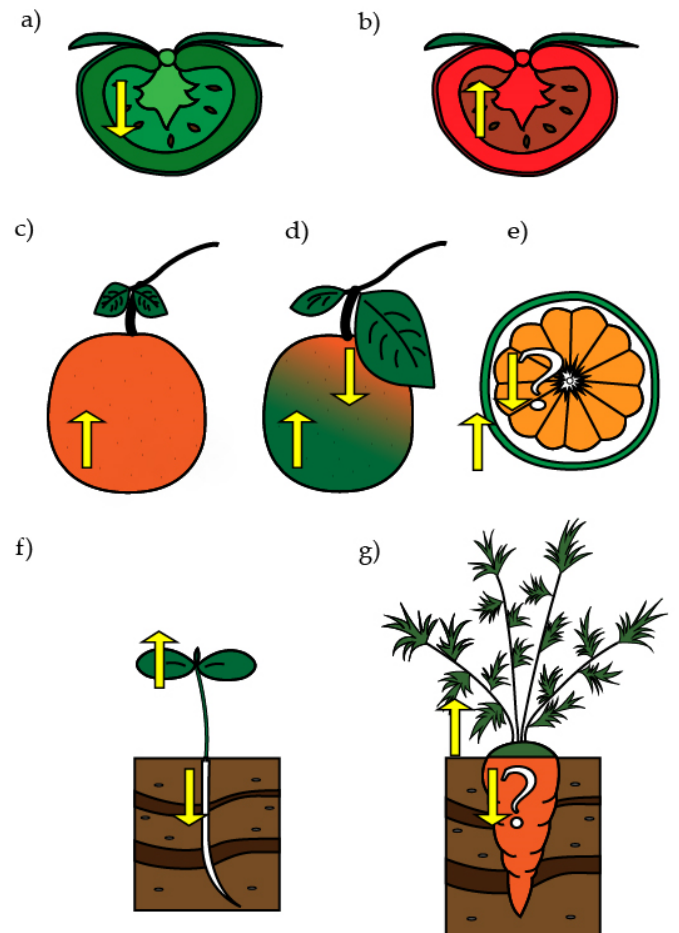
Figure 3. Effect of light on carotenoid synthesis in different plant organs. ( a ) Tomato fruit in MG stage exhibits chloroplasts in low R/FR light. ( b ) Tomato fruit in RR stage presents chromoplasts in high R/FR light. ( c ) Citrus fruit in the ripening stage accumulates carotenoids in high R/FR light. ( d ) Grapefruits accumulate more carotenoids in the pericarp in low R/FR light in comparison with high R/FR light. ( e ) Navel orange ( Citrus sinensis O. ), Star Ruby grapefruit, and Miyagawa wase ( Citrus unshiu M. ) are examples in which, at the breaker (B) stage, carotenoids in chromoplasts are produced in the flesh, whereas in the pericarp, which is exposed to high R/FR, carotenoids are produced in chloroplasts. ( f ) In Arabidopsis ( Arabidopsis thaliana L.) seedling, high R/FR light induces photomorphogenesis. ( g ) In carrots ( Daucus carota L.), a high R/FR produces chloroplast development, whilst a low R/FR induces carotenoid accumulation on chromoplasts. Yellow upwards arrows indicate a high R/FR light ratio while downwards arrows indicate a low R/FR light ratio.